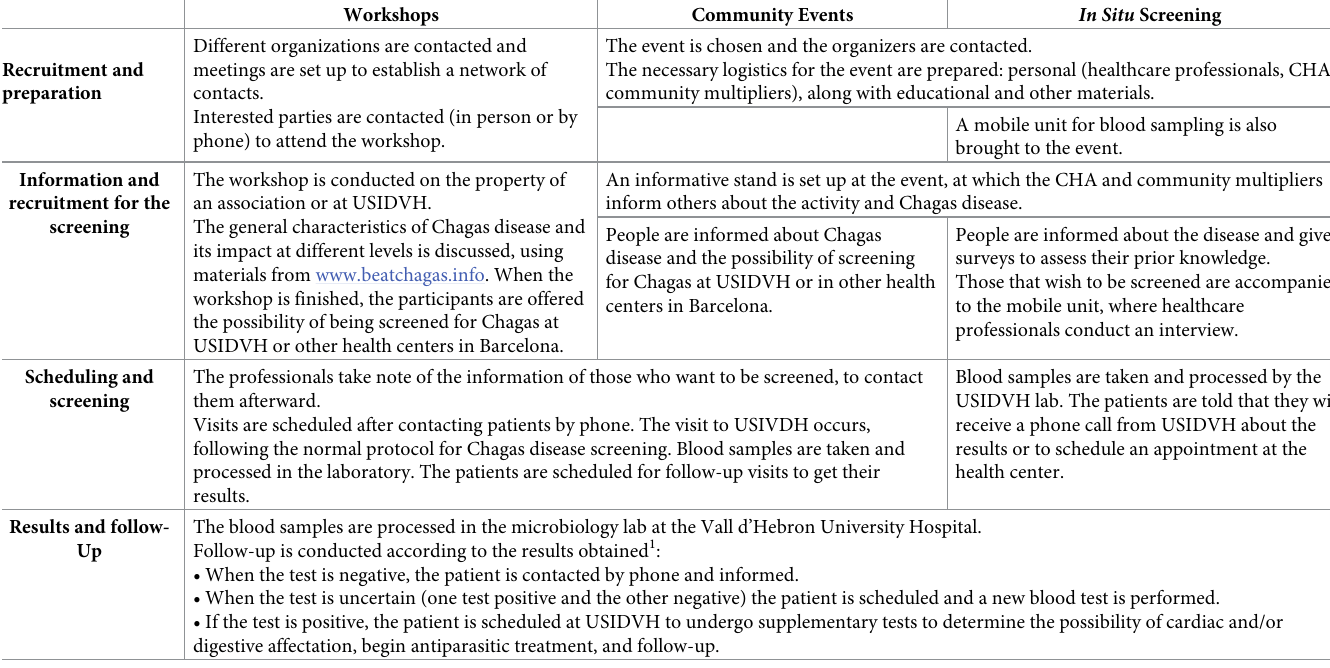
Table 2. Description of the different developmental phases of the implemented community strategies.